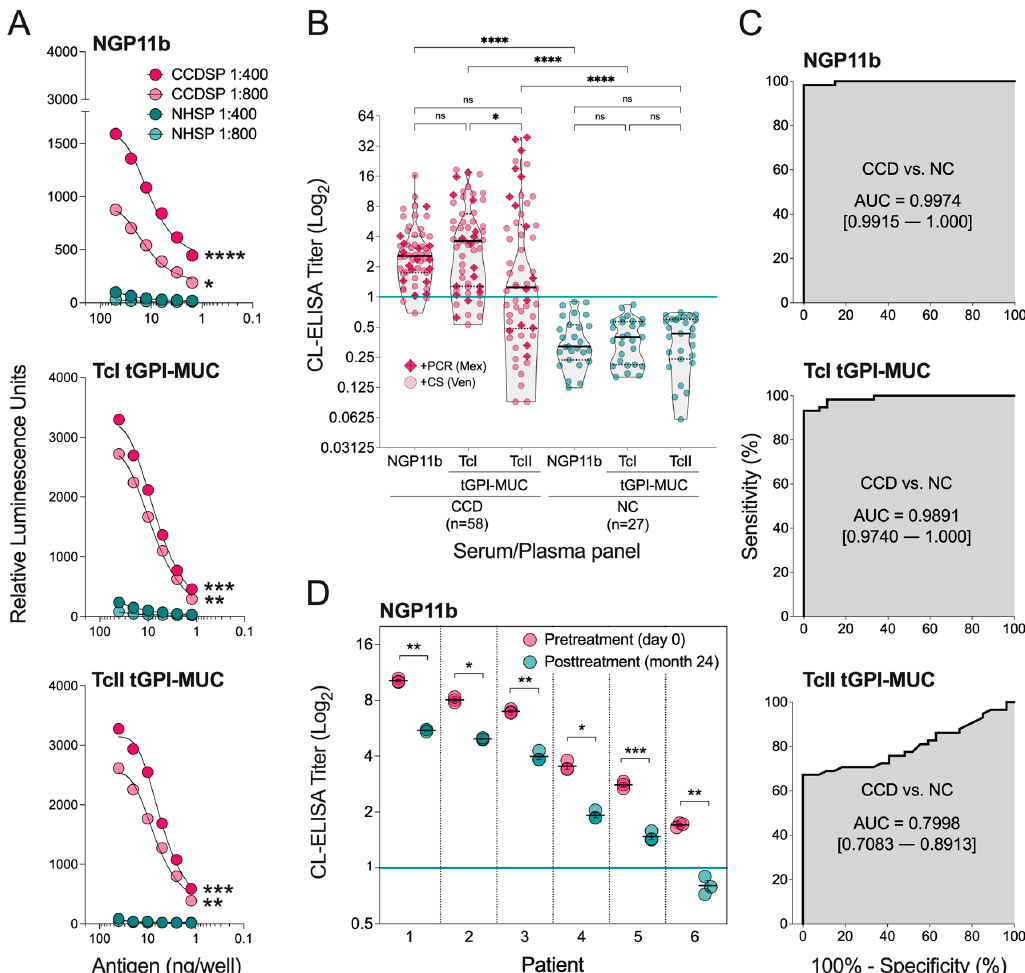
Figure 2. Serological evaluation of NGP11b, TcI tGPI-MUC, and TcII tGPI-MUC by CL-ELISA. ( A ) Cross-titration of varying concentrations (50, 25, 12.5, 6.2, 3.1, and 1.6 ng/well) of synthetic NGP11b (top panel), and purified TcI tGPI-MUC (from Colombiana strain, 40-2 ng/well) (middle panel) and TcII tGPI-MUC (from Y strain, 40–2.5 ng/well) (bottom panel) at 1:400 and 1:800 serum dilutions. The CCD serum pool (CCDSP) ( n = 10) was obtained from CCD patients from Venezuela. The normal human serum pool (NHSP) ( n = 10) was obtained from healthy donors from the U.S.A. ( B ) CL-ELISA titers of sera (at 1:800 dilution) of individual CCD patients ( n = 58), from Venezuela ( n = 42) and Mexico ( n = 16), and umbilical cord plasma (at 1:400 dilution) samples of healthy individuals, negative control (NC) ( n = 27) from the U.S.A. to NGP11b, TcI tGPI-MUC, and TcII tGPI-MUC. Serum samples from Mexico (Mex) with a confirmed CD diagnosis by positive PCR (+PCR), and from Venezuela (Ven) with a confirmed CD diagnosis by positive conventional serology (+CS), are indicated by different symbols. Green line, cutoff value (CL-ELISA titer = 1.000), calculated as described in Materials and Methods. ( C ) ROC curves for NGP11b, TcI tGPI-MUC, and TcII tGPI-MUC comparing the reactivity of sera from CCD patients vs. healthy individuals, using the data depicted in the truncated violin scatterplot ( B ). Statistical analysis: Kruskal–Wallis test with Dunn’s multiple comparison test with Geisser–Greenhouse correction. * p < 0.05; ** p < 0.01; *** p < 0.001; **** p < 0.0001. The area under the curve (AUC) (gray area) and its value are indicated. The 95% confidence interval (CI) values are shown in brackets. ( D ) CL-ELISA titers of CCD patients before treatment (day 0) and after treatment (24 months) with the standard of care of benznidazole (150 mg twice a day, for 60 days). Statistical analysis: mixed-effects model with Geisser–Greenhouse correction. * p < 0.05; ** p < 0.01; *** p < 0.001.